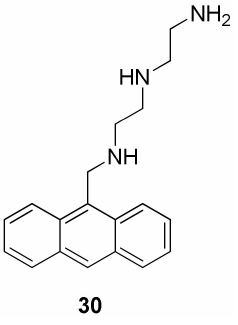
Figure 8. Structure of an anthracene with a polyamine